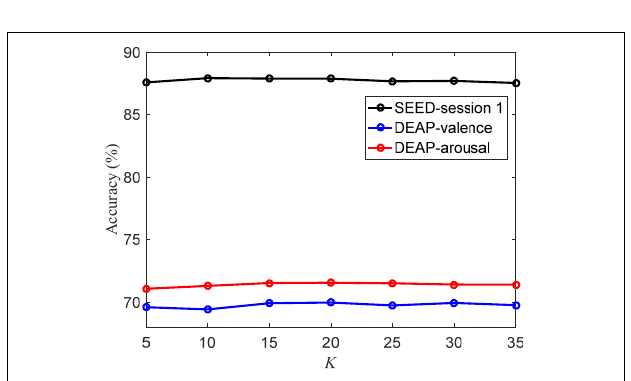
FIGURE 8 | Classification accuracy of MBCC vs. different K on the SEED and DEAP